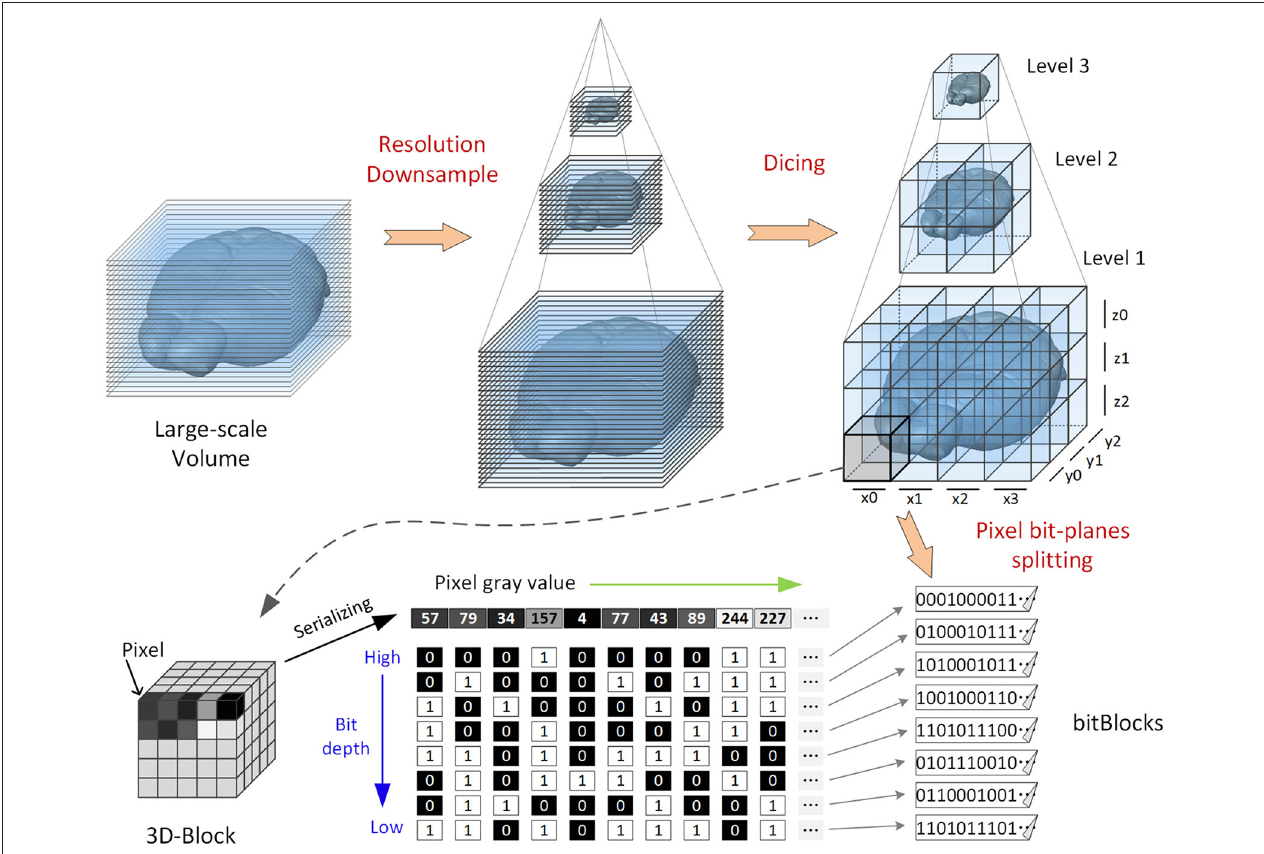
FIGURE 1 | Illustration of a bit-plane-separated, fine-grained data format. The original volumetric data are recursively downsampled to generate three datasets with different resolution levels (for illustrative purposes). Each dataset is first diced into 3D blocks; then, the 3D blocks are split by bit depth, and the split results (bitBlocks) are stored separately.